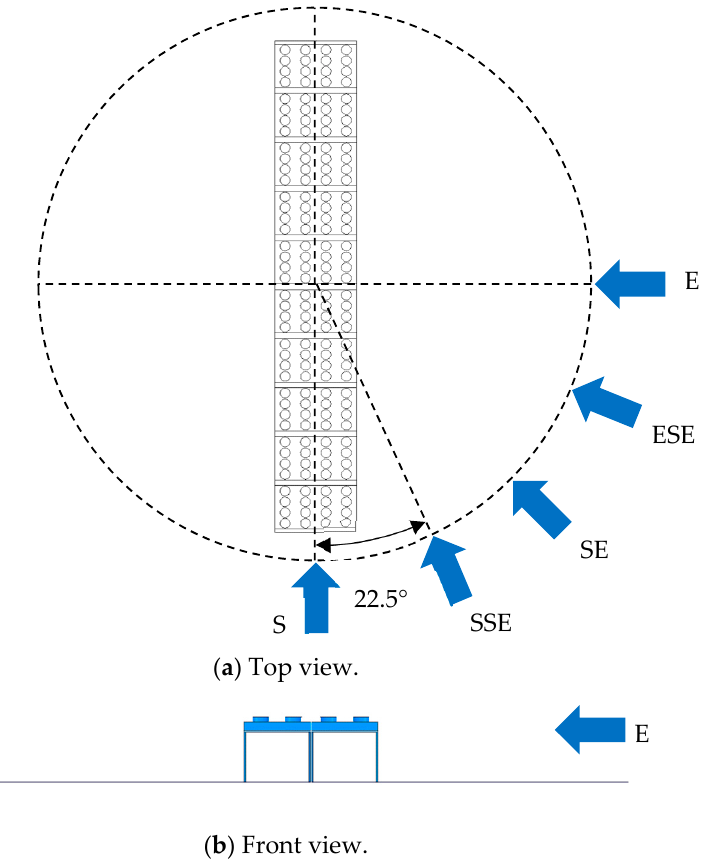
Figure 2. Sketch of the 20 evaporators, from top view ( a ) and front view ( b ), under different wind conditions in the computational fluid dynamics (CFD) simulations, for a uniform field. The domain size around the evaporators is discussed in Section 2.4.1.